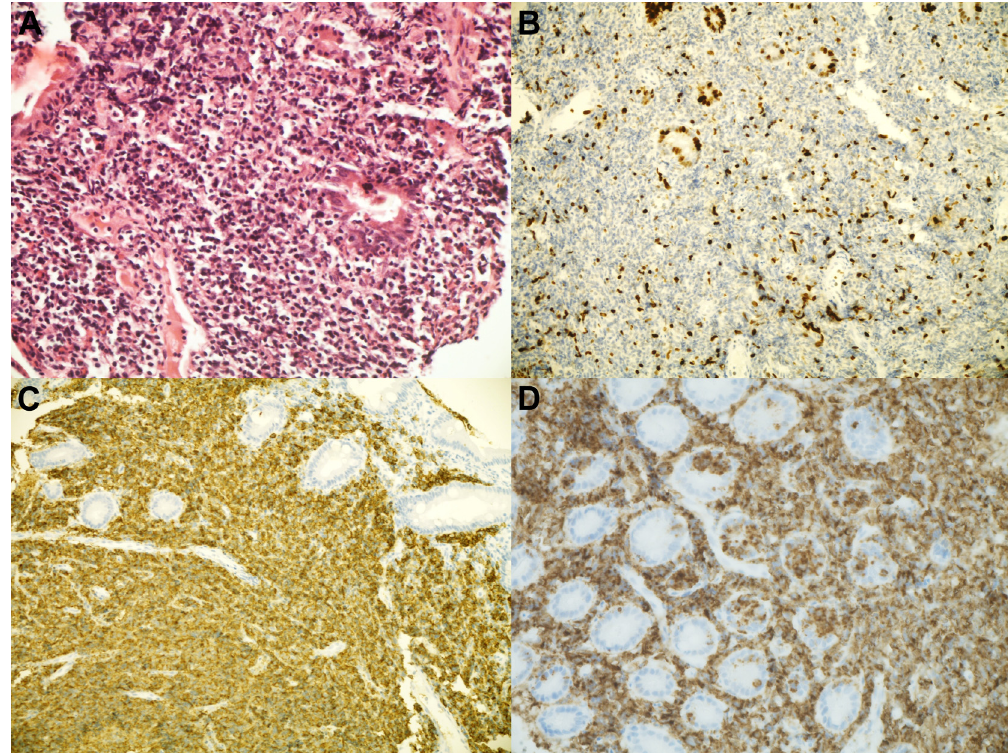
Fig. 3A. Hematoxillin-eosin staining 3B. Ki 67 stain 3C. difuse infiltrate of CD 20- positive B lymphoid cells (margine zone cells) 3D. Lymphoepithelial